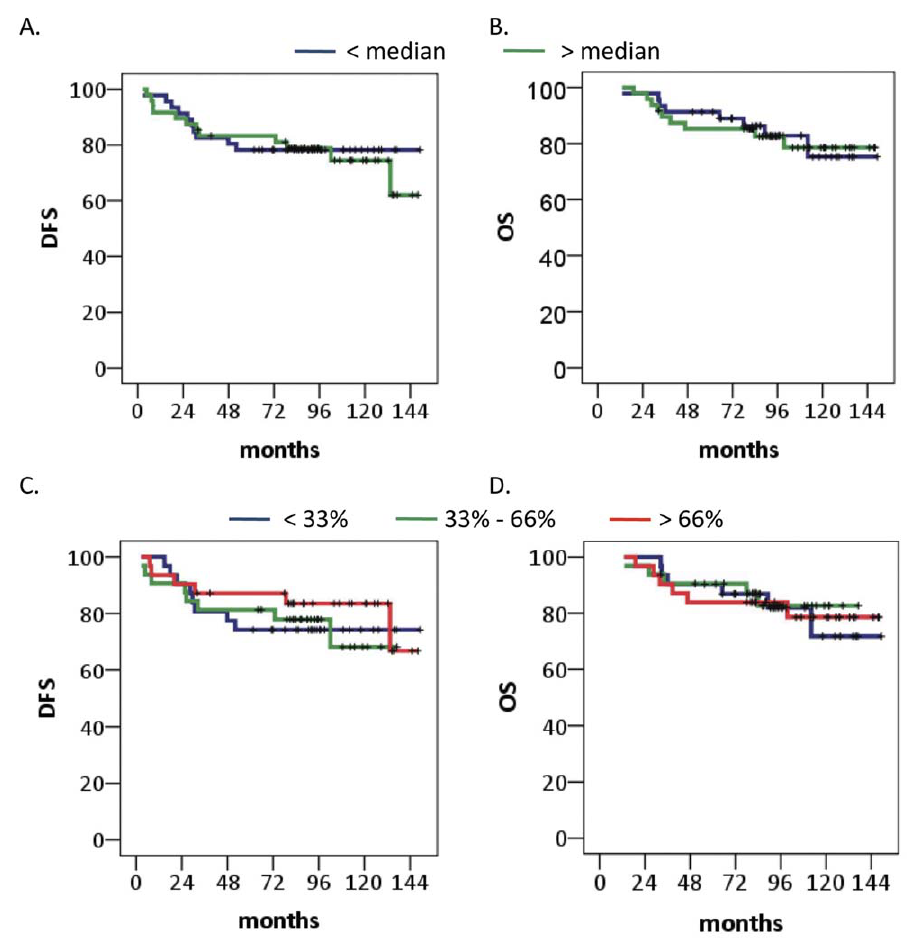
Figure 5. Breast cancer patient survival based on miRNA-24 expression levels. A. Disease free survival in patients stratified according to miRNA-24 expression below or above median. B. Overall survival in patients stratified according to miRNA-24 expression below or above median (0.9 6 10 2 3 ). C. Disease free survival in patients stratified according to tertiles miRNA-24 expression below 0.5 6 10 2 3 , above 1.2 6 10 2 3 or in between. D. Overall survival in patients stratified according to tertiles miRNA-24 expression below 0.5 6 10 2 3 , above 1.2 6 10 2 3 or in